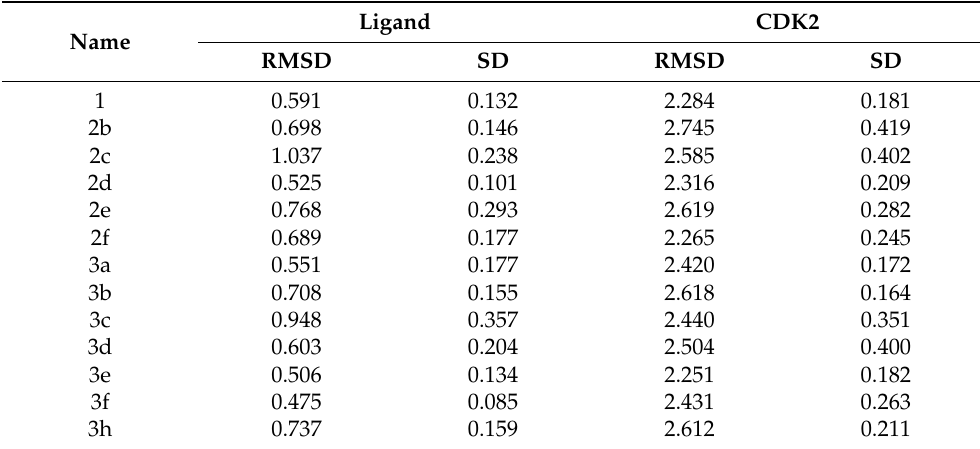
Table 4. The averaged values of RMSD for ligands and CDK2 protein for all steps used during structural